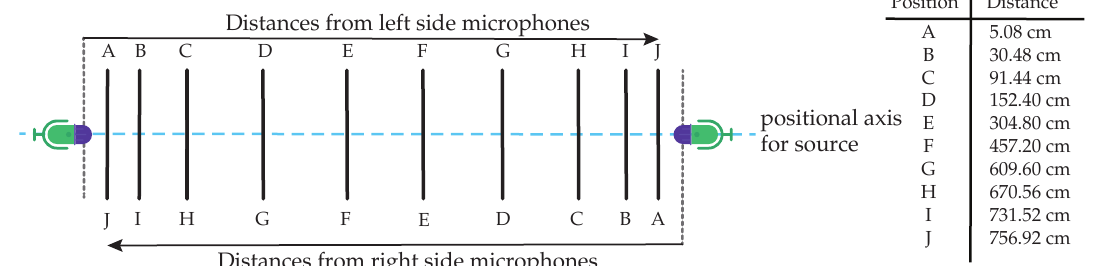
Figure 2. Various distances from left and right microphones. Figure 3. Various distances from left and right